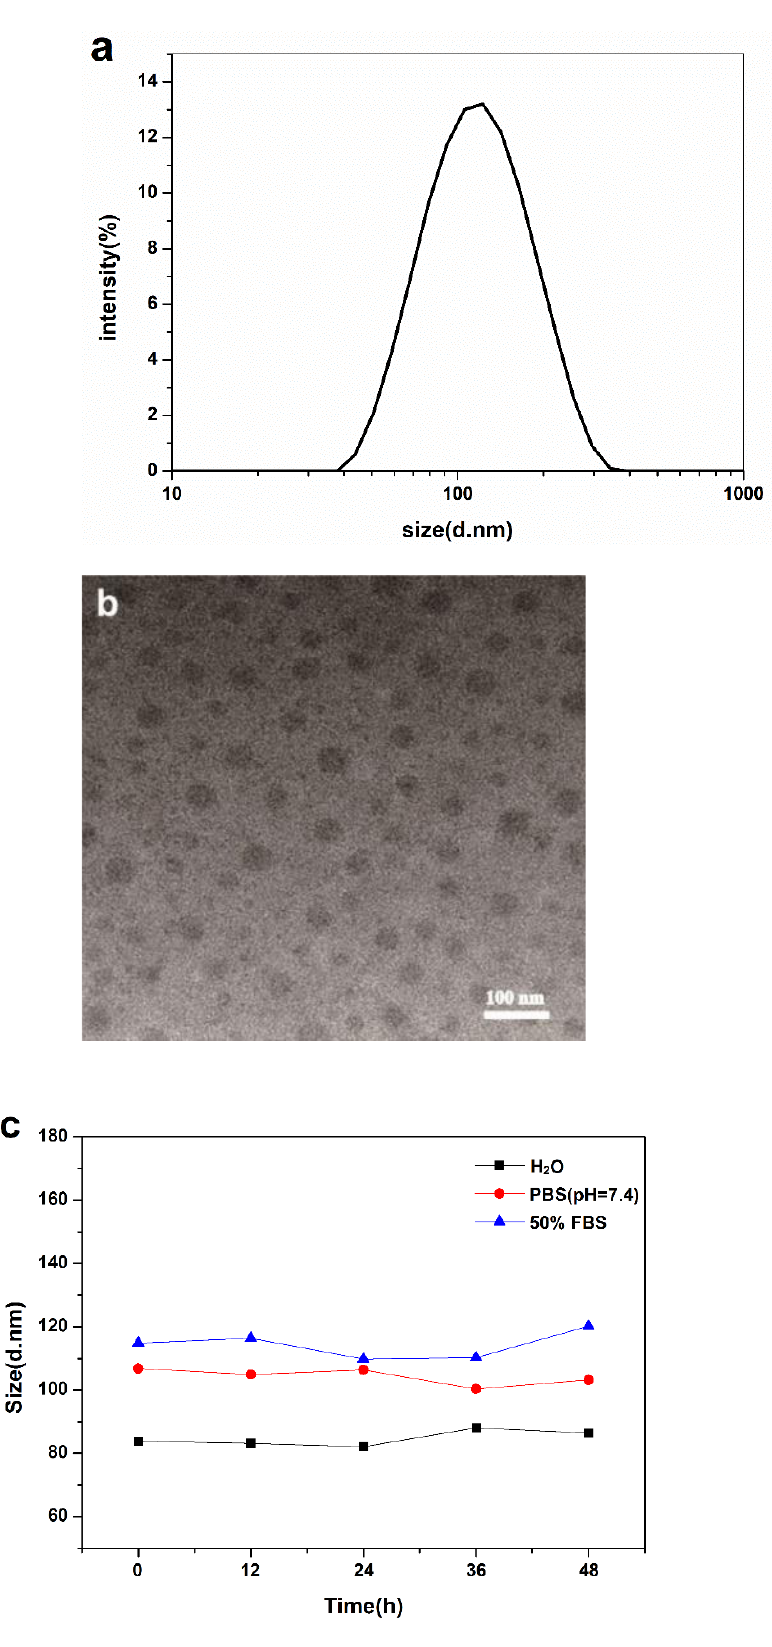
Figure 1. Characterization of BSA nanoparticles: size measurement by DLS ( a ); TEM image of BSA nanoparticles ( b ); particle size variation of BSA-NPs for 48 h in DI water, PBS (pH = 7.4) and 50% FBS ( c ).